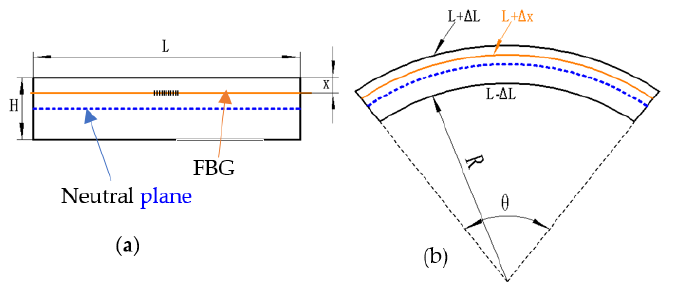
Figure 1. Bending mechanism of the elastic material: ( a ) Stress-free without bending, ( b ) stress and bend.